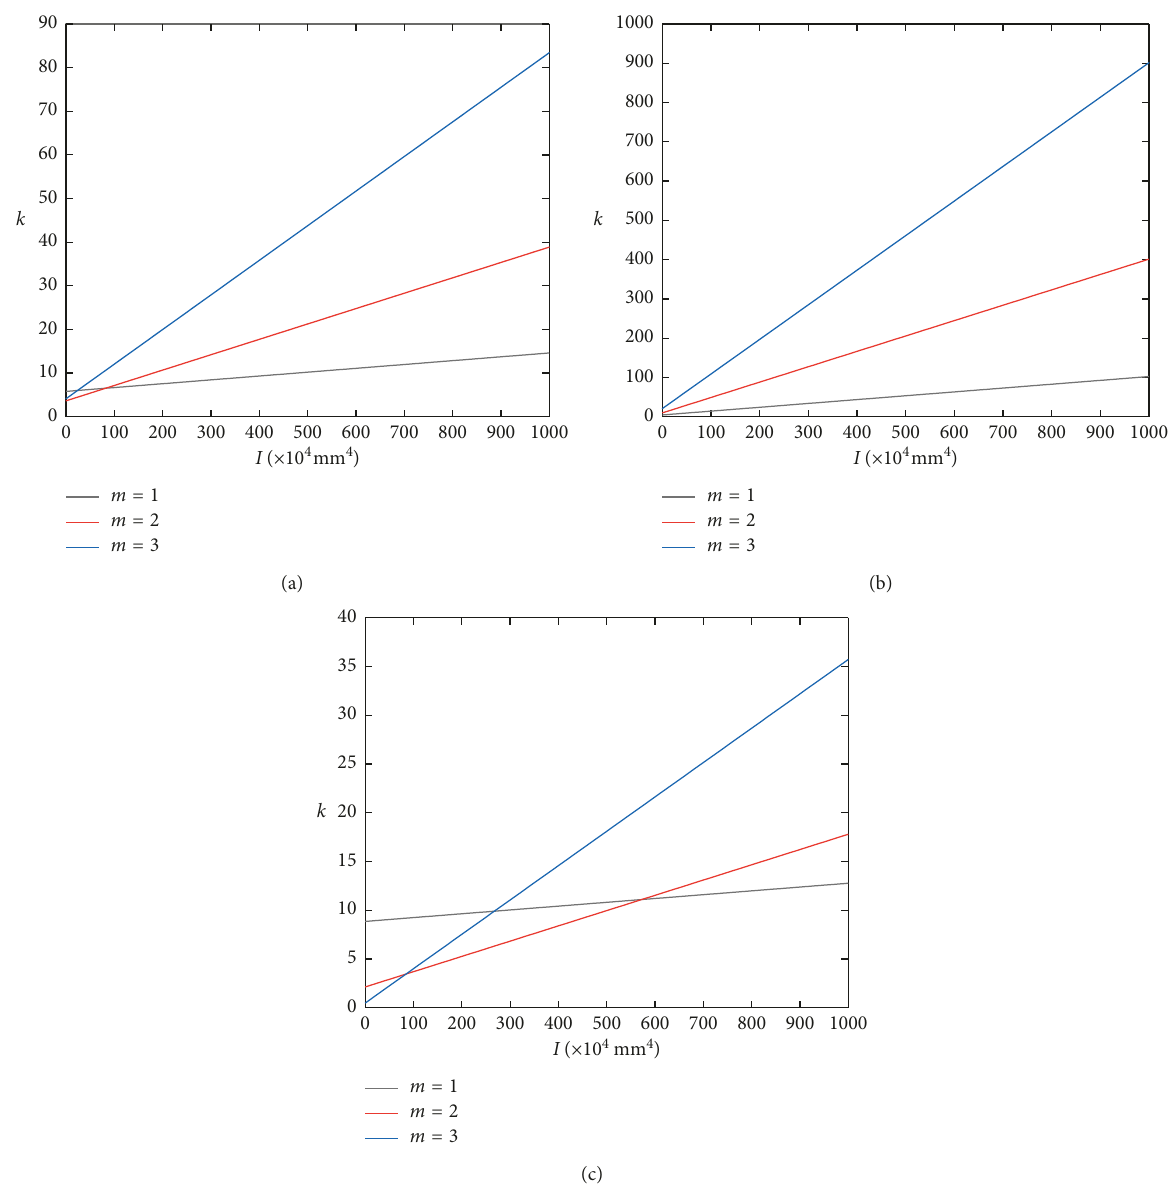
Figure 7: Relation between critical buckling load coefficient k and rib inertia moment for (a) β